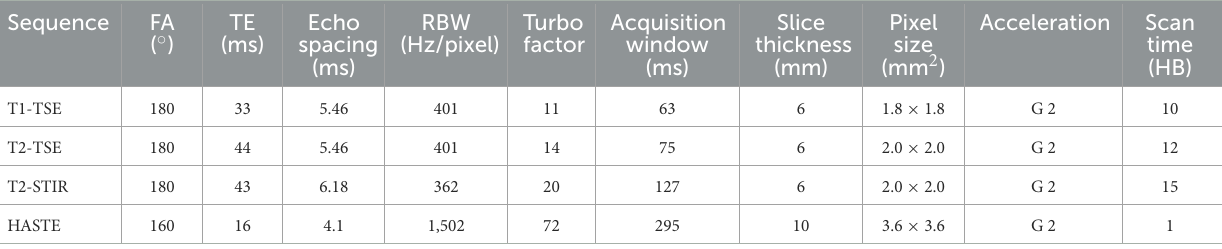
TABLE 3 Image acquisition parameters for dark-blood cardiac sequences.